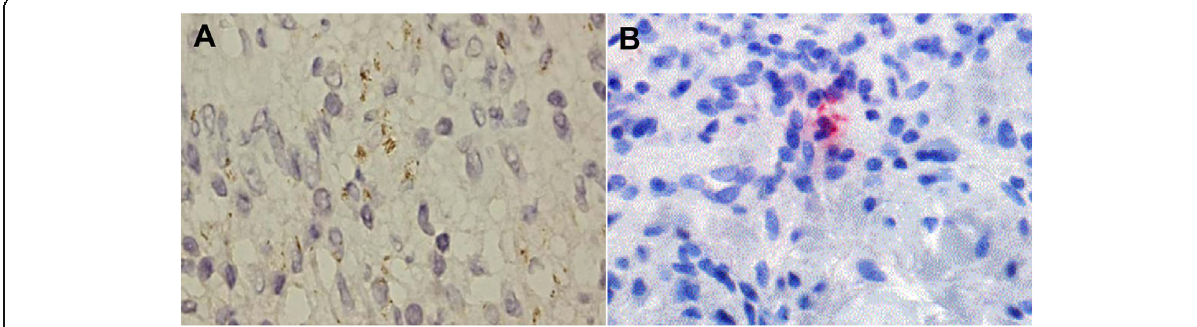
Fig. 4 A Immunohistochemistry for syphilis showing spirochetes in the cytoplasm of histiocytes (1000x, oil immersion). B. Immunohistochemistry showing C. trachomatis particles in lesional